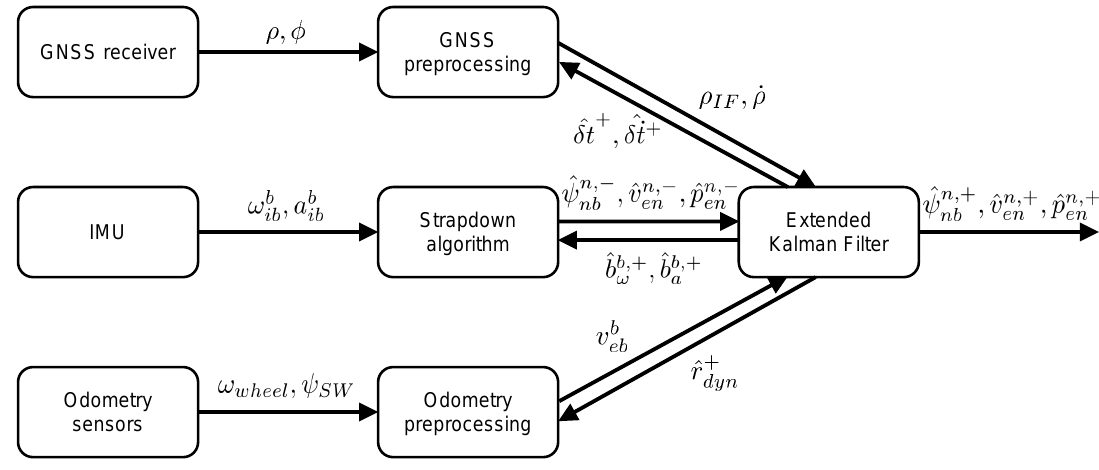
Figure 1. Block diagram of the tightly coupled GNSS/IMU/odometry integration algorithm. Superscript − denotes estimated values before the EKF’s measurement update, superscript + denotes updated estimates after the EKF’s measurement